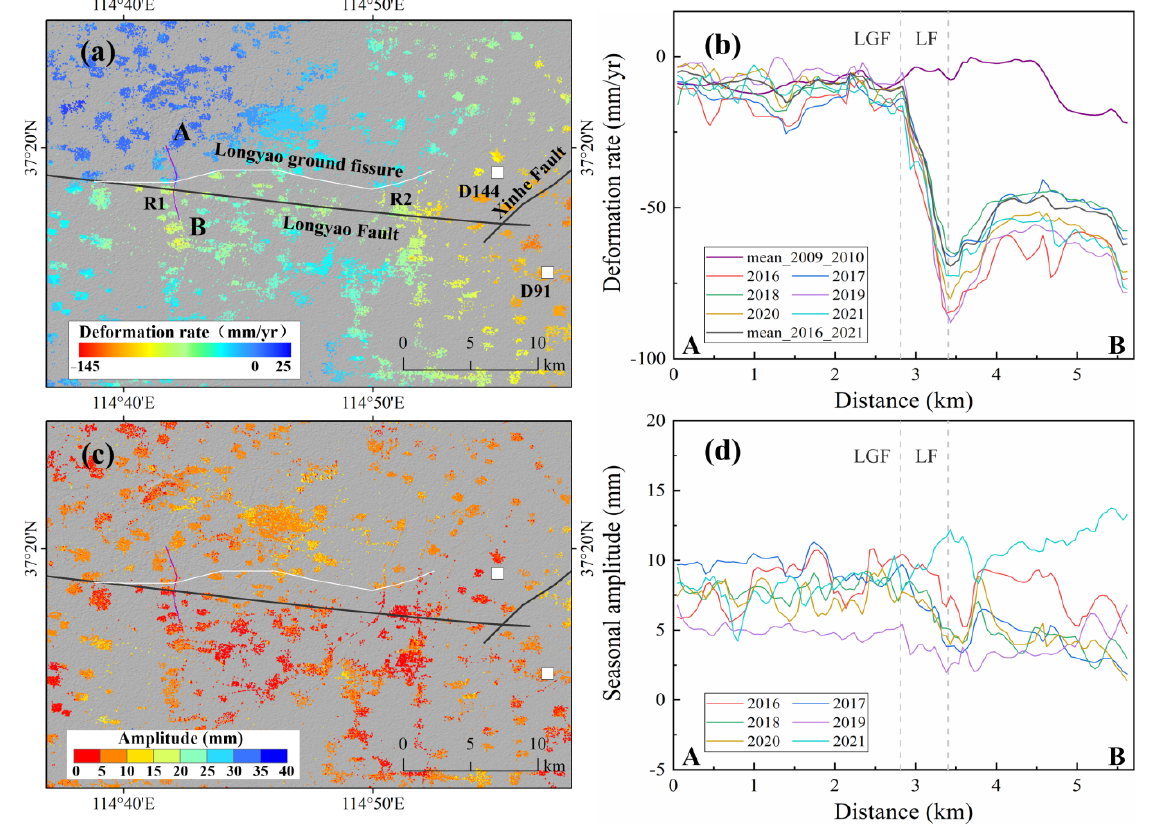
Figure 9. ( a ) The map of InSAR-derived land deformation rate during 2015~2021 in Zone A. ( b ) The profile of deformation rate across the Longyao ground fissure and Longyao Fault during 2009~2010 and 2016–2021. ( c ) The map of amplitude of seasonal deformation in 2018 over Zone A. ( d ) The profile of amplitude of seasonal deformation along the line of AB during 2016–2021. The purple line marks the profile line, the white line represents the Longyao ground fissure, the black lines mark the faults, and the white squares represent the observation wells.